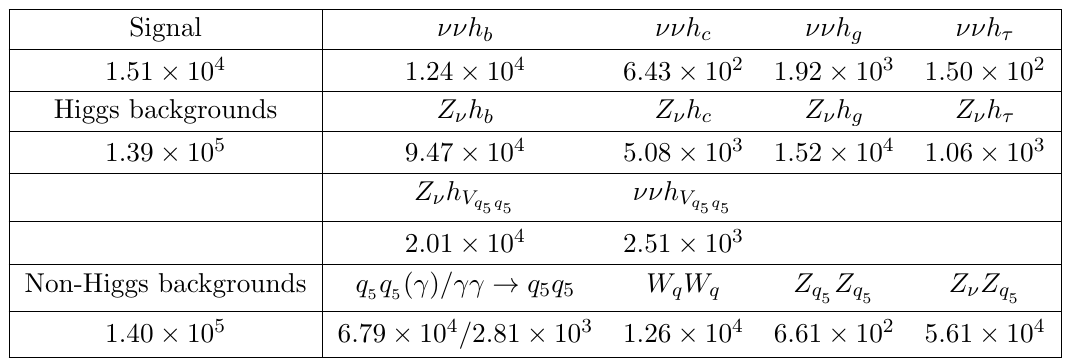
Table 6 . Numbers of the signal and its main background events after preselection, for measuring (cid:27) ( (cid:23)(cid:23)h h ). 4.3 Measuring (cid:27) ( (cid:23)(cid:23)h )BR( h ! hadrons) In Method B, (cid:27) ( (cid:23)(cid:23)h ) is a crucial intermediate quantity to measure. As is shown in table b